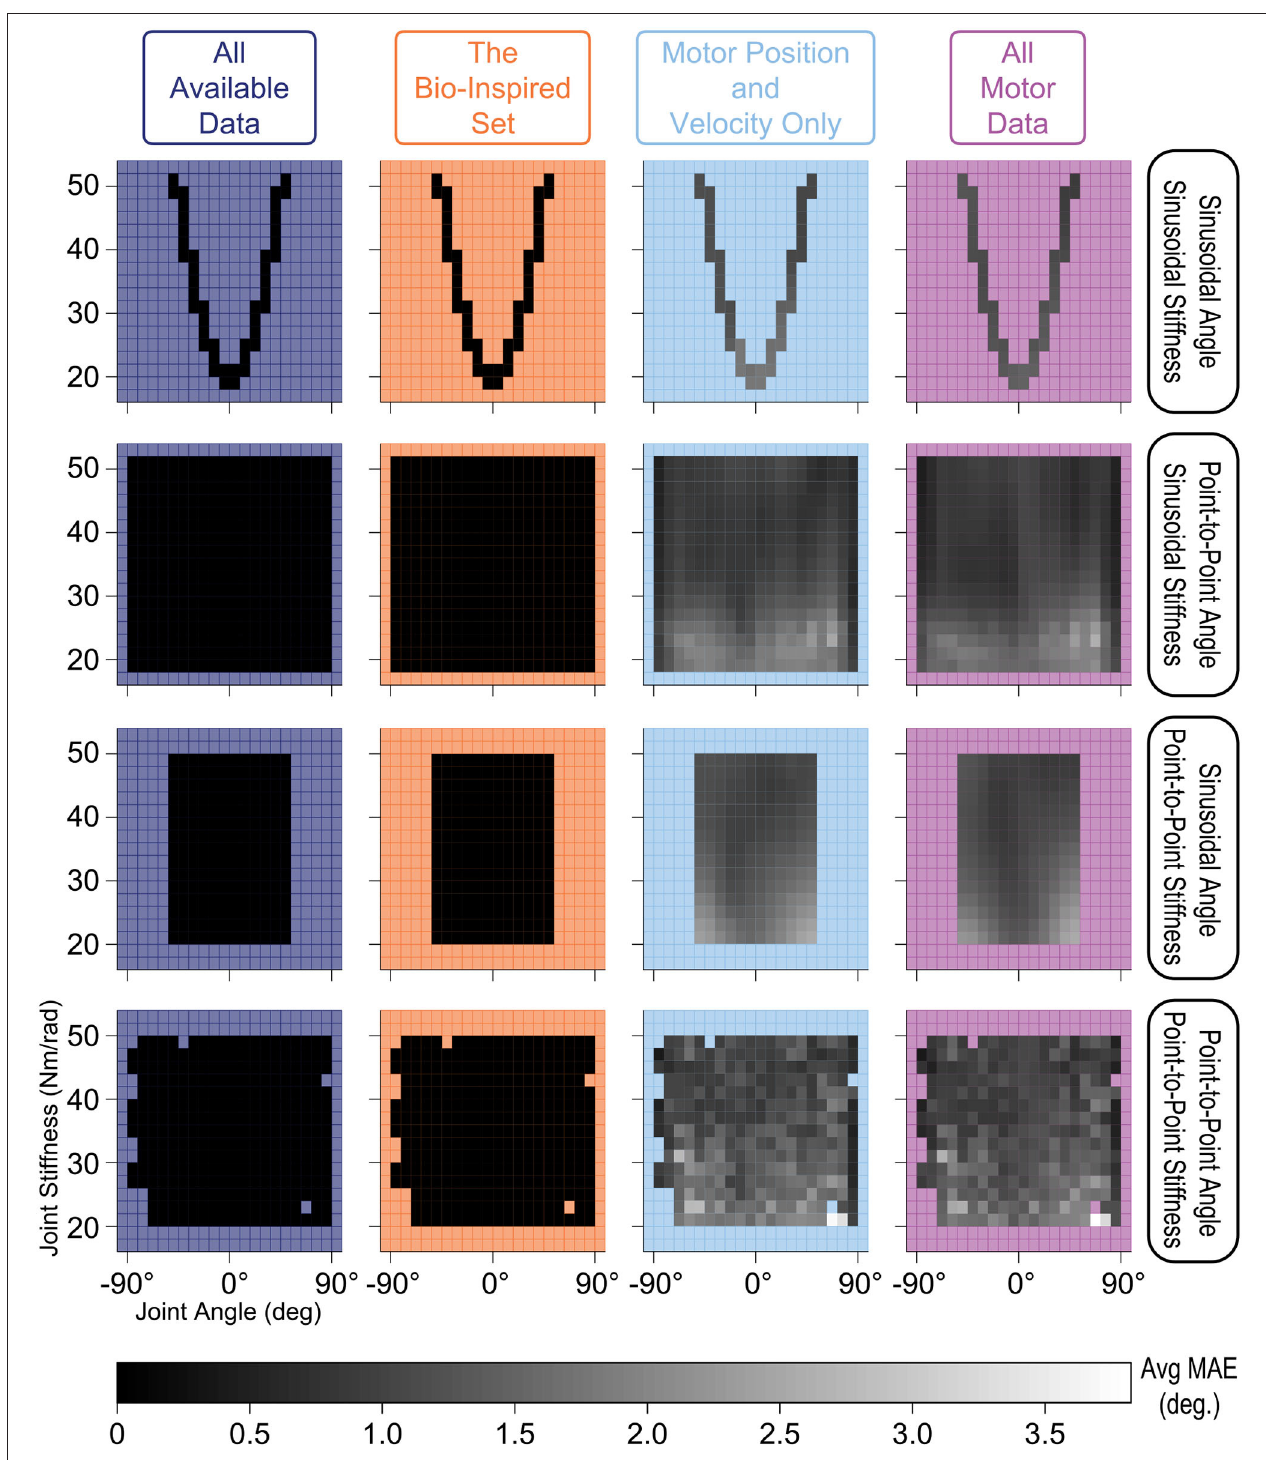
FIGURE 10 | Linear-scale heatmap of the average MAE vs. joint angle and joint stiffness for sinusoidal and point-to-point trajectories (default Low tendon stiffness experiment). It is clear that the ANNs trained with tendon tension ( left two columns ) reliably predicted joint angles at any level of joint stiffness, while the ANNs trained without tendon tension ( right two columns ) had difficulty at low joint stiffness values (regardless of the type of movement). This is because tendon tensions that produce lower joint stiffness occupy the more nonlinear “toe” region of the tension-stretch relationship (i.e., more disproportionate lengthening per unit force) which causes more nonlinear decoupling between motor and kinematics